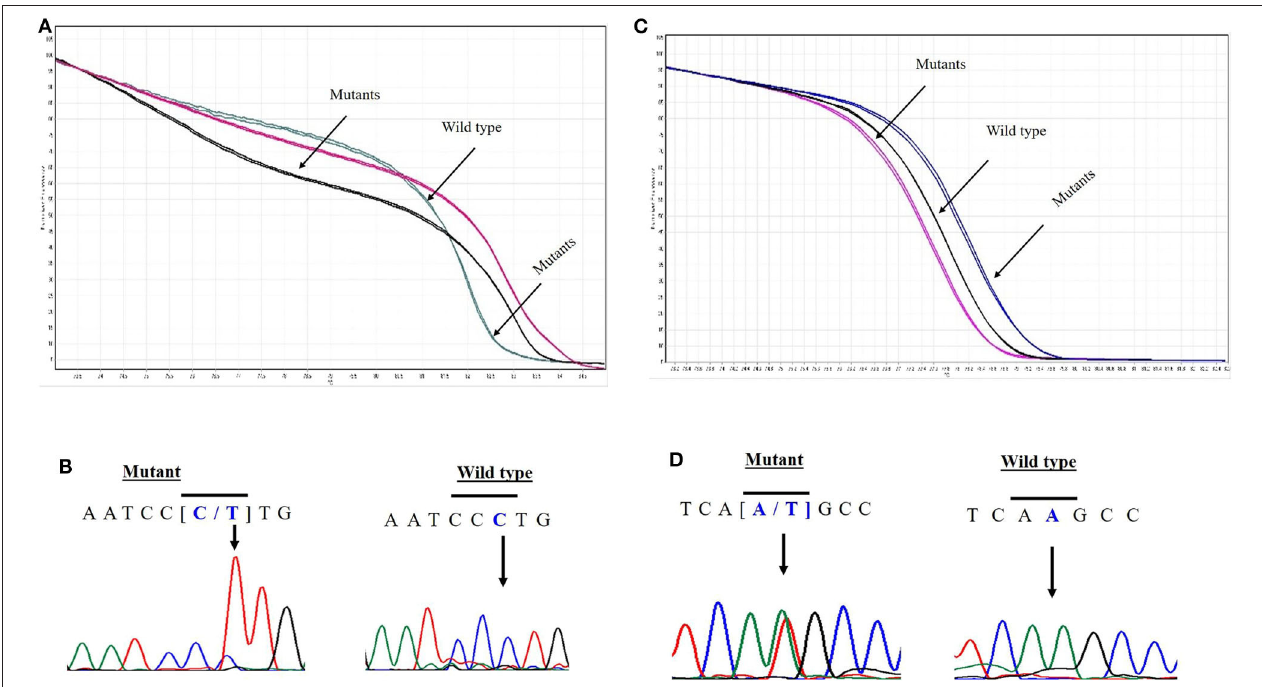
FIGURE 2 | Novel variants in EPAS1 detected in ESCC tissues. Comparison of HRM curve analysis and Sanger sequencing of the variants identified in patients with ESCC. Representative HRM curve (A) and chromatograph (B) for the synonymous mutation c.1084C > T (L362L). Representative HRM curve (C) and chromatograph (D) for the frameshift variant c.1091_1092insT (K364Nfs*12).